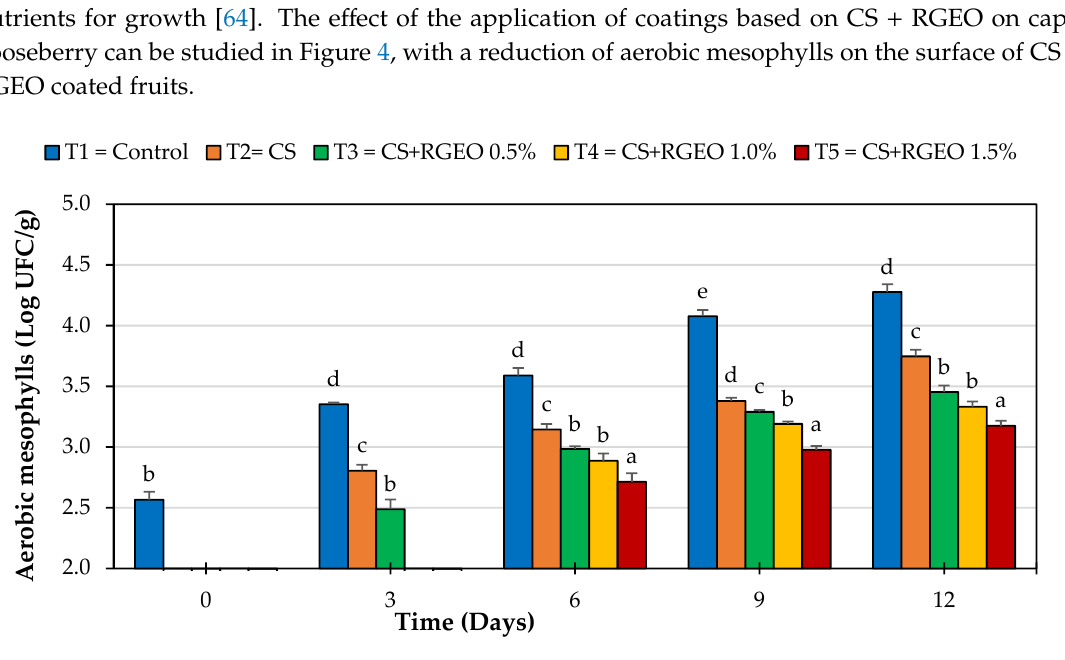
Figure 4. Aerobic mesophylls count for the treatments applied to cape gooseberry. The superscript letter (a–d) refers to the significant differences ( p < 0.05) between each treatment.